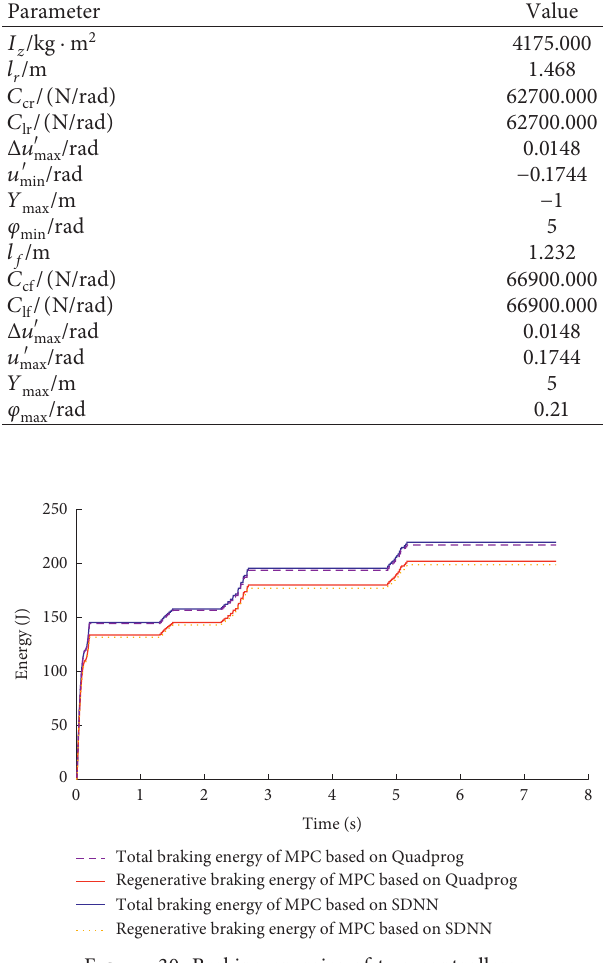
Figure 30: Braking energies of two controllers.